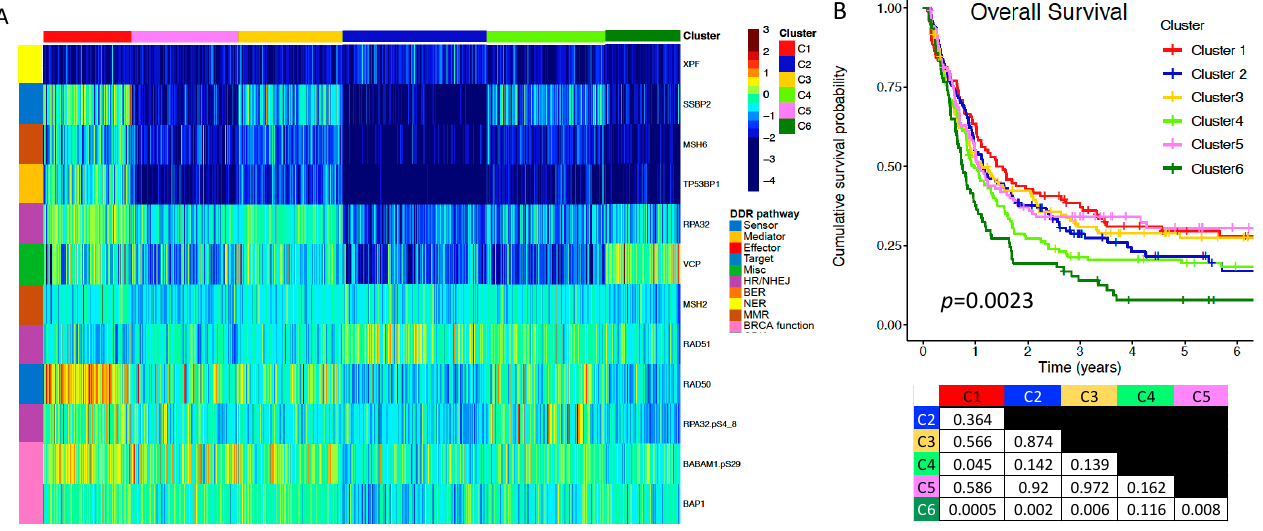
Figure 2. A subset of DDR proteins is prognostic for overall survival. ( A ) A subset of 12 DDR proteins (shown on the right side of the heatmap) from the original set of 21 reveals 6 AML patient clusters (labeled at the top of the heatmap) with distinct protein expression patterns. The heatmap itself displays the expression levels of this subset of DDR proteins in all patients. Proteins downregulated in expression relative to normal CD34+ cells are colored in cooler colors approaching deep blue, while upregulated proteins are colored in warmer colors approaching burgundy. ( B ) Maintaining the same cluster color designation, the overall survival (OS) for these 6 clusters is shown in the cumulative survival probability diagram ( n = 684). Below the OS curves is a table displaying statistical comparison p -values between all combinations of cluster pairs.